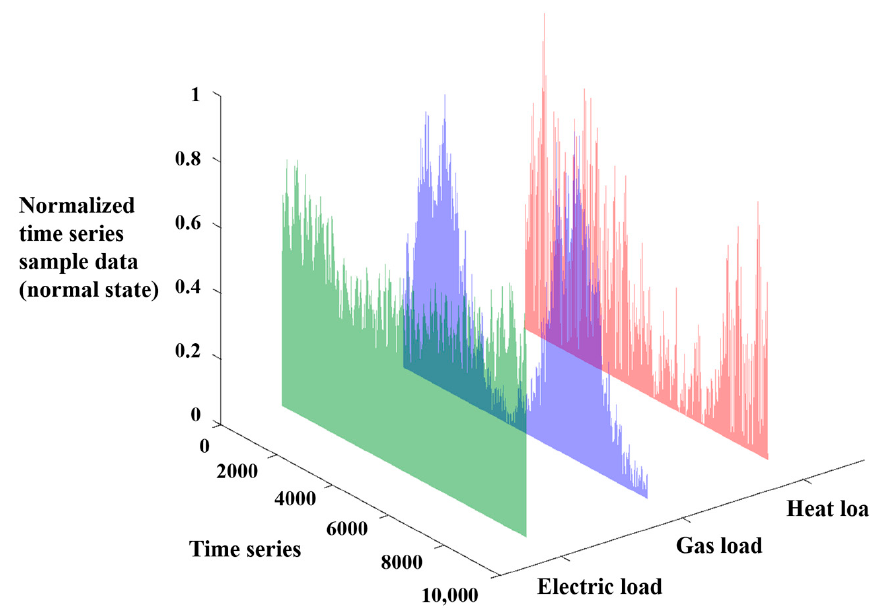
Figure 16. Normalized time-series sample dataset under normal state.